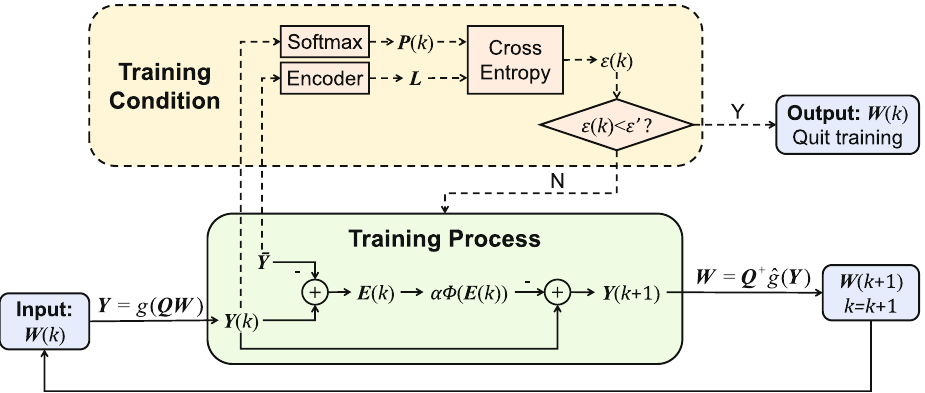
Figure 2. Diagram of neural dynamic learning algorithm (NDLA). If training error ε( k ) calculated by the class possibility matrix P ( k ) and the label matrix L satisfies ε( k ) ≥ ε ′ , where ε ′ denotes a threshold, the weight matrix connecting between hidden and output layers W ( k ) will be updated as W ( k + 1 ) at the ( k + 1 ) th training round under the situation of known NDLA design coefficient α , mapping function Φ( · ) , hidden output matrix Q , the ¯ Y diagnosis deviation matrix E , predicted diagnosis output matrix Y , and the label matrix